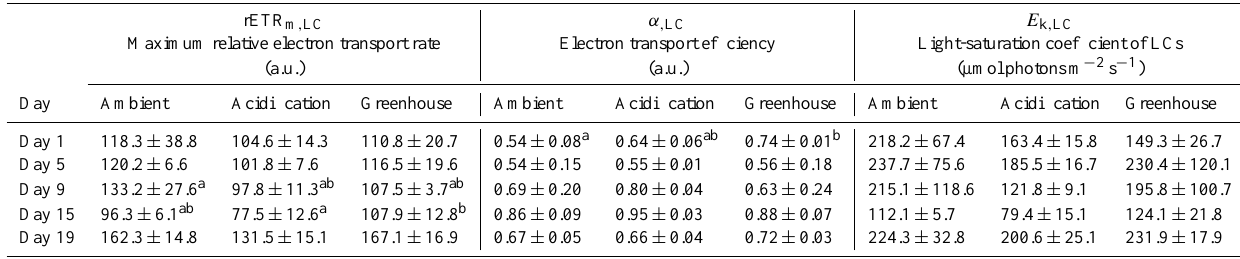
Table 1. Photosynthetic parameters from steady-state light response curves (LCs) of phytoplankton community during the experimental period. Different letters indicate a significant difference based on Tukey’s multiple comparison ( p